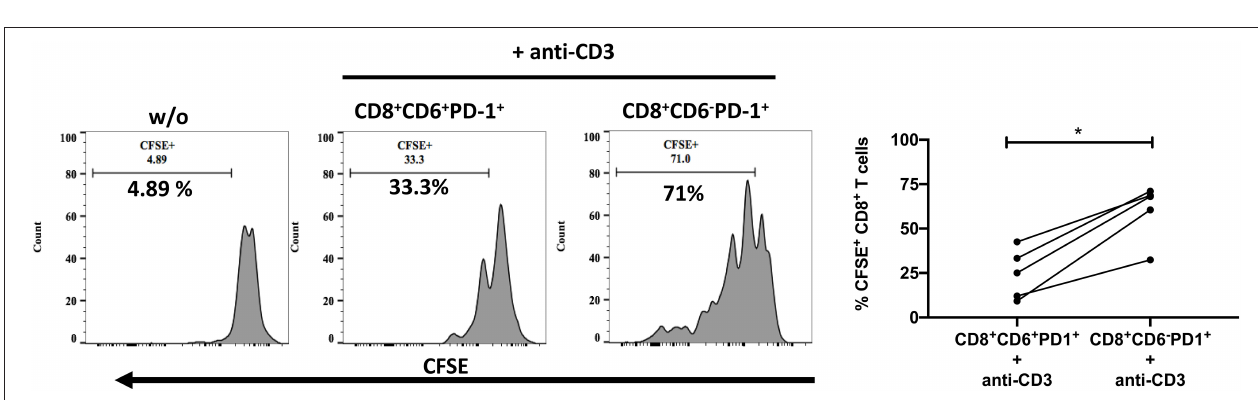
FIGURE 5 | Overexpression of CD6 and PD-1 is associated with reduced proliferation. Representative staining and the frequency of splenic CD8 + CD6 + PD-1 + and CD8 + CD6 − PD-1 + T-cell CFSE dilution on day 3 following in vitro anti-CD3 stimulation. Data are from 5 macaques. Data are shown as means ± SEM. For statistical analysis, Mann-Whitney tests were performed. * p <